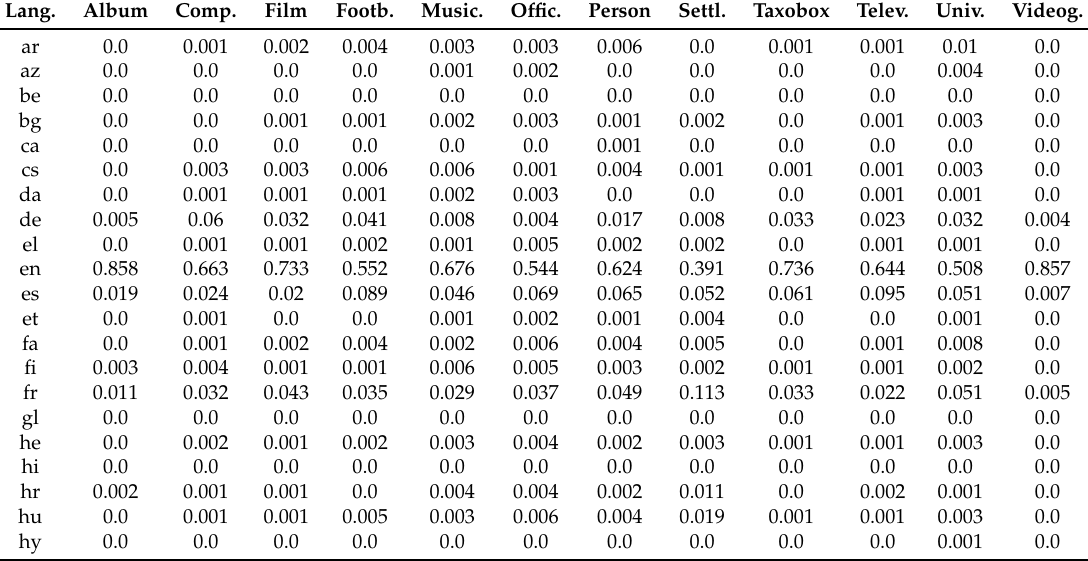
Table A2. Shares of Wikipedia articles with the highest popularity compared with other language versions (articles with at least three language versions were considered). Source: own